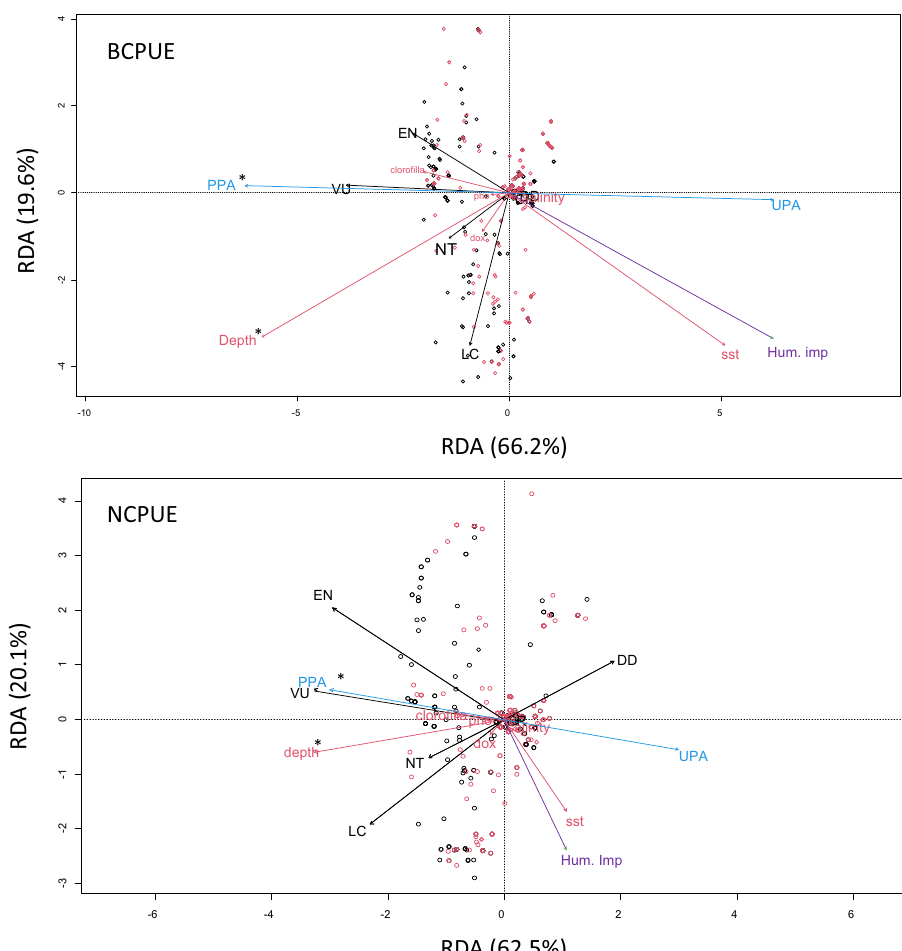
Fig. 4 | Partial distance-based redundancy analysis (pRDA) performed on BCPUE (upper panel) and NCPUE (lower panel). In the biplot diagrams, the spe- cies are grouped into the IUCN categories (CR=Critically Endangered; EN= Endangered; VU=Vulnerable; NT=Near Threatened; LC=Least Concern; DD= Data De fi cient). Arrows indicate the correlations among variables: a longer arrow indicatesthatthecorrespondingvariableismoreimportant;asmallanglebetween